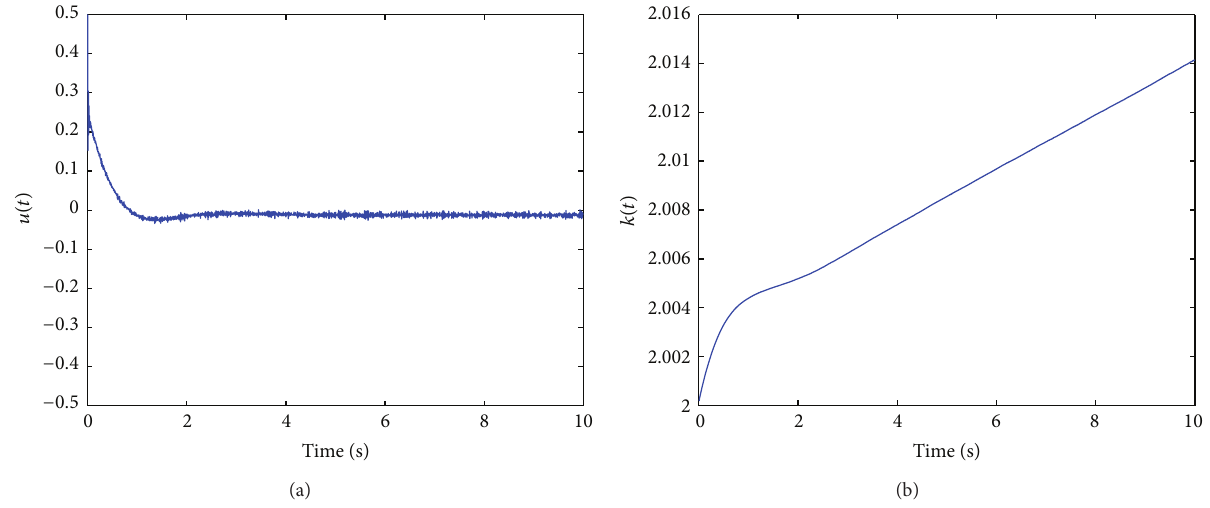
Figure 4: (a) Control input with TPASMC. (b) Adaptive gain